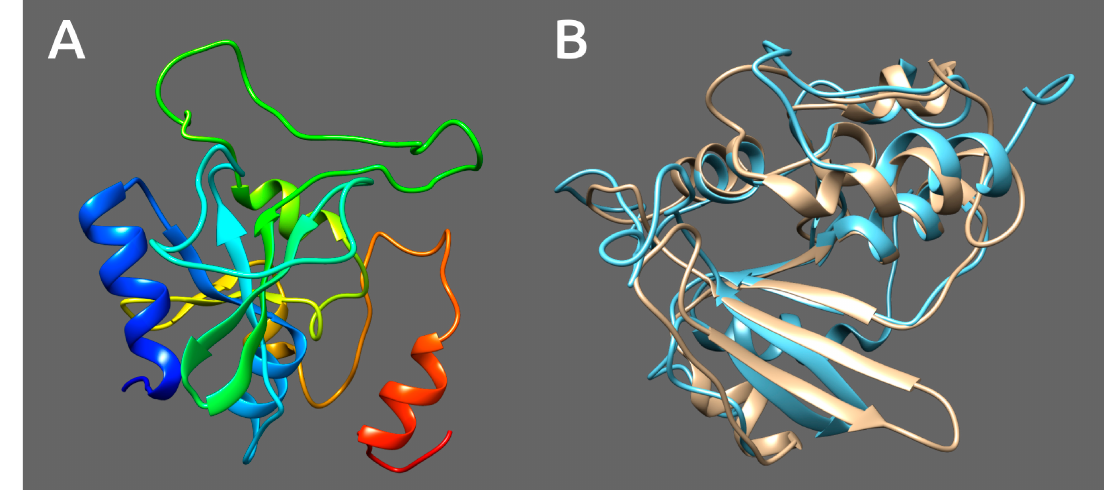
Figure 13. ( A ) 3D structure homology modelling of tRNA-nycleotidyltransferase from Pectobacterium phage PP47. The model is colored based on a rainbow gradient scheme, where the N-terminus of the polypeptide chain is colored blue and the C-terminus is colored red. ( B ) 3D-alignment of modelled tRNA-nycleotidyltransferase from Pectobacterium phage PP47 (colored blue) and Pectobacerium aroidearum PC1 (colored sand).